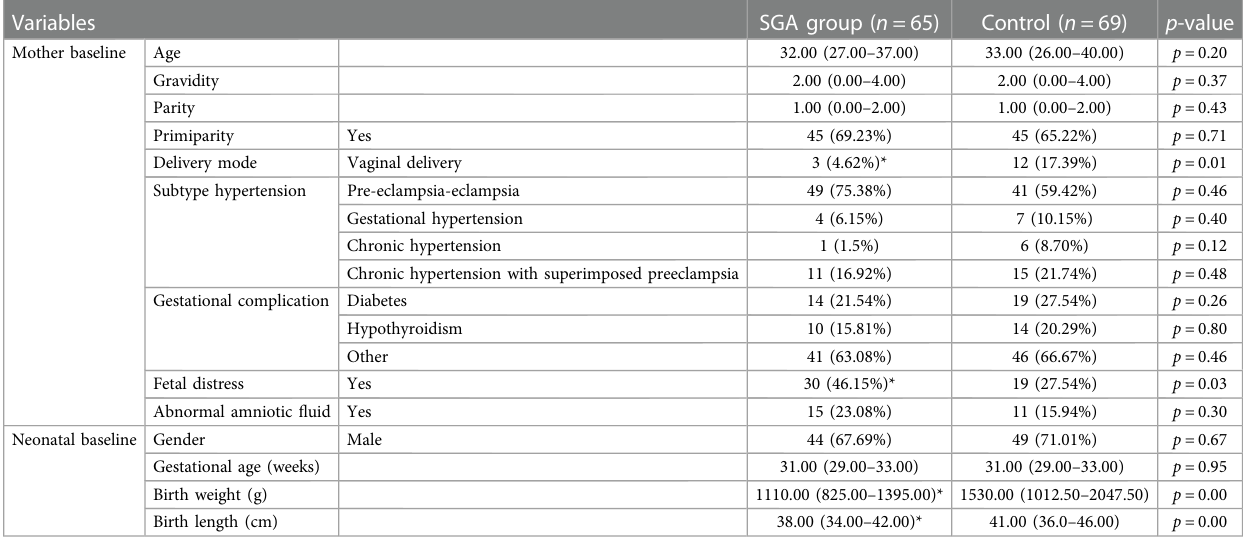
TABLE 1 Demographic and clinical characteristics of preterm neonates and their